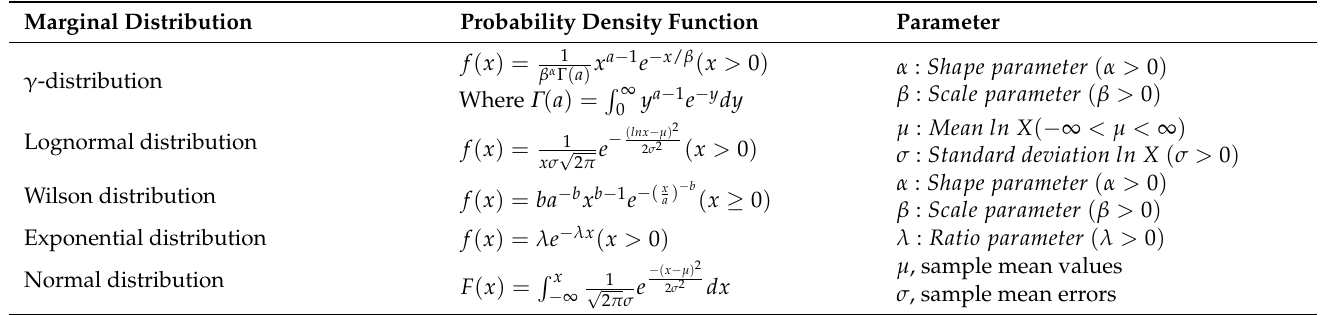
Table 2. Probability density function and parameters of different probability distributions.